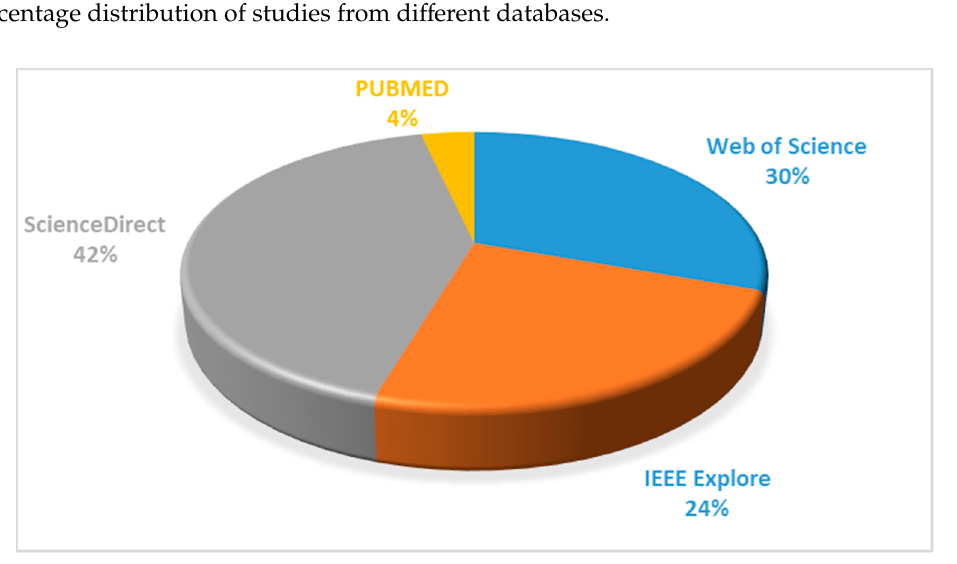
Figure 2. Distribution of studies obtained from four databases after the initial search query.